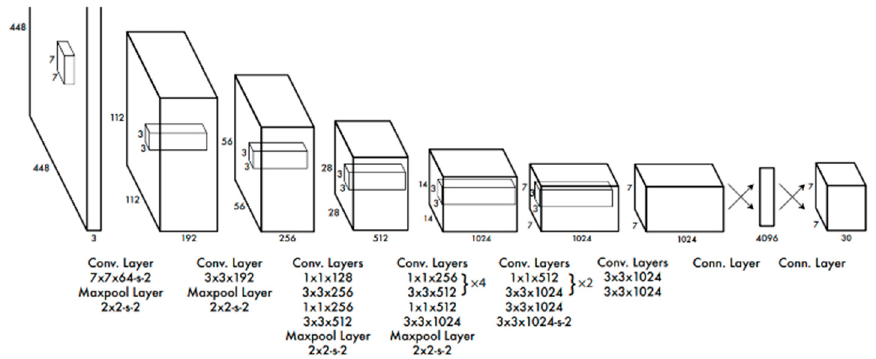
Figure 3. 24 convolutional layers followed by 2 fully connected layers for You Only Look Once (YOLO) version 1.